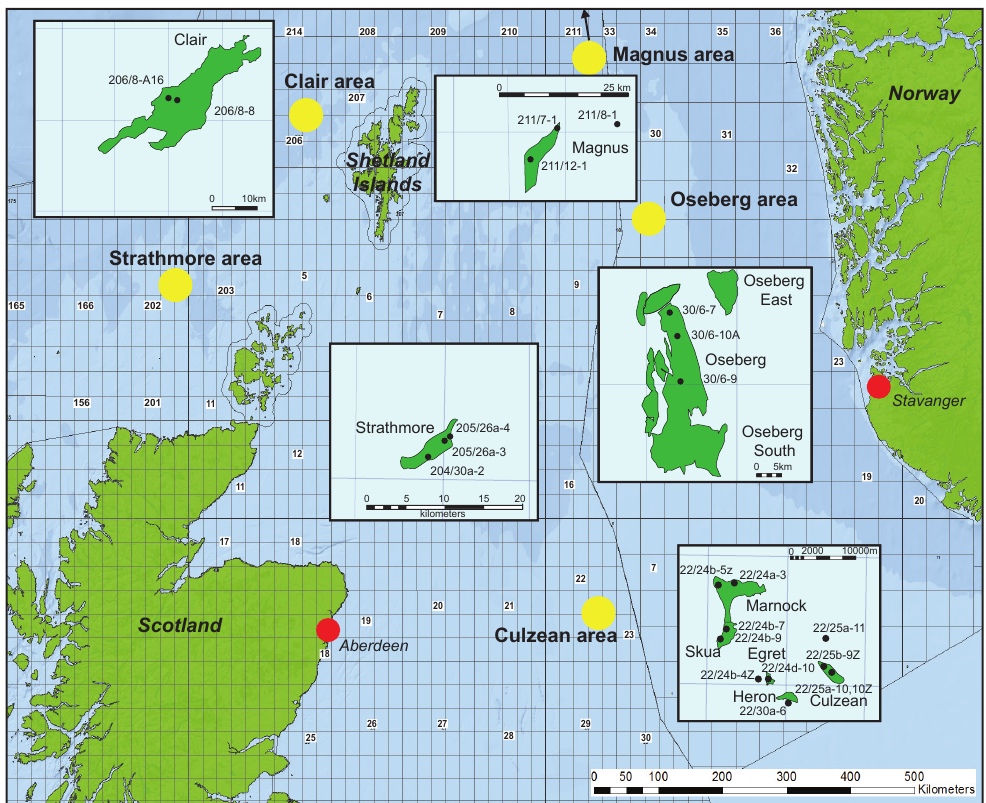
Figure 1. Location map of the North Sea and west of Shetland areas showing the oil and gas fields discussed in this paper. Numbers are the UK and Norwegian